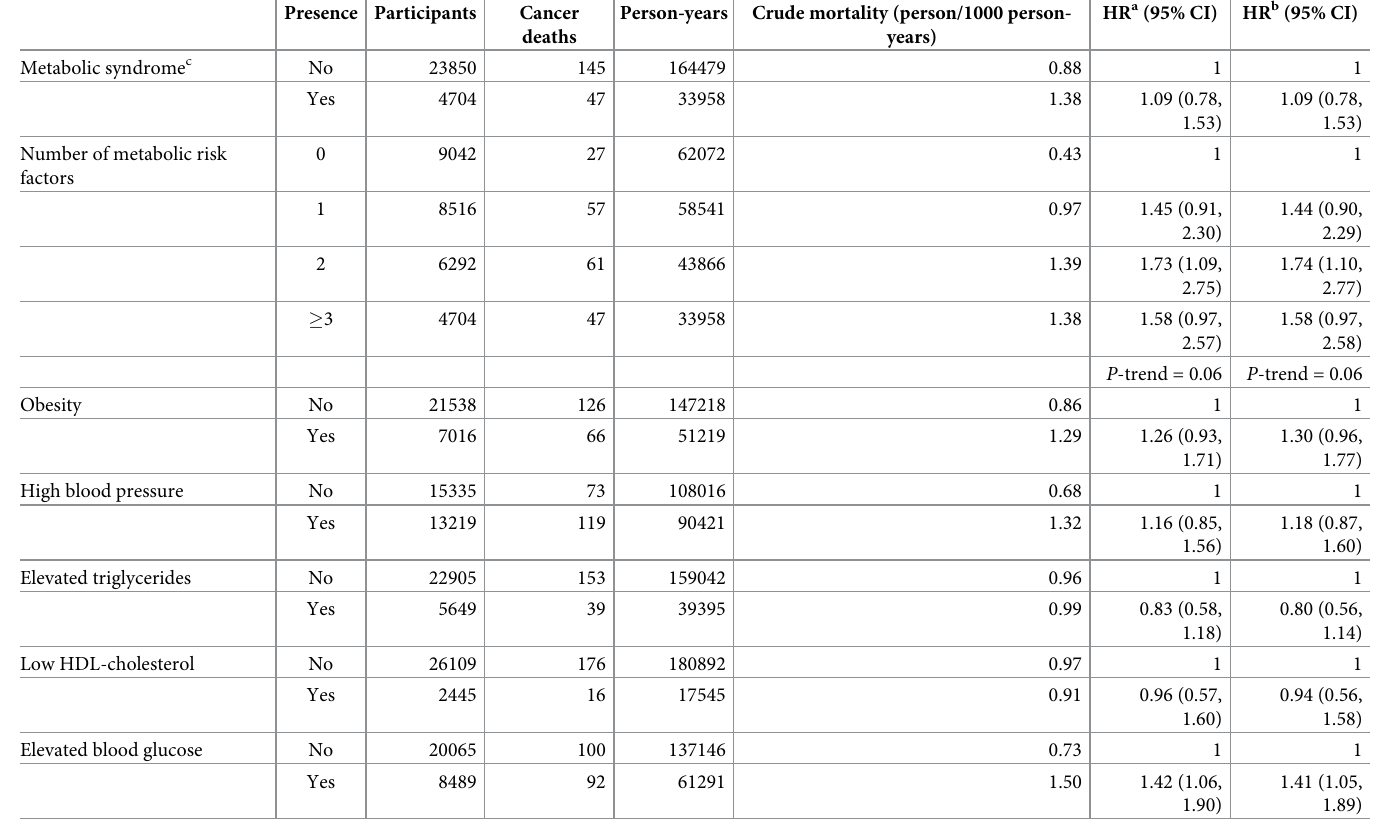
Table 2. Hazard ratios and 95% confidence intervals for total cancer mortality in relation to metabolic syndrome and its components.